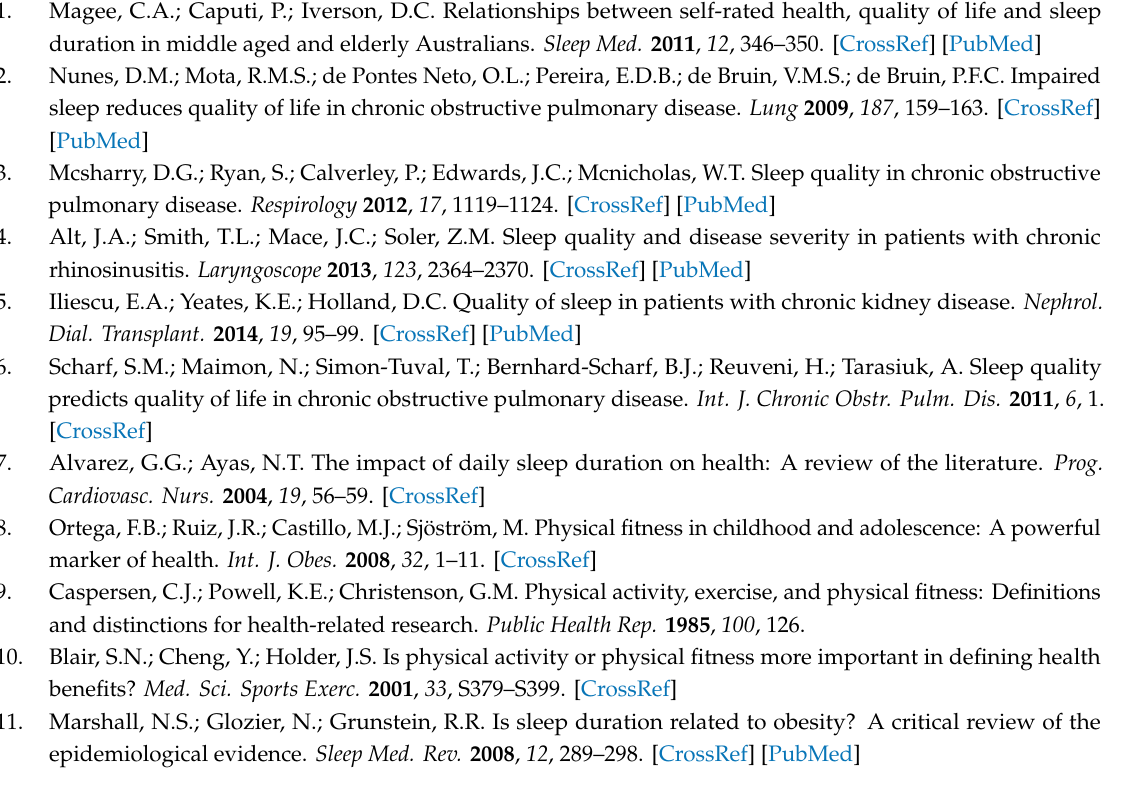
Table S1: Estimation results of the MARS model for BMI—male, Table S2: Estimation results of the MARS model for BMI—female, Table S3: Estimation results of the MARS model for sit-ups—male, Table S4: Estimation results of the MARS model for sit-ups—female, Table S5: Estimation results of the MARS model for sit-and-reach-male, Table S6: Estimation results of the MARS model for sit-and-reach—female, Table S7: Estimation results of the MARS model for CEI—male, Table S8: Estimation results of the MARS model for CEI—female. Figure S1: Trend diagram of the sleep condition and BMI—male, Figure S2: Trend diagram of the sleep condition and BMI—female, Figure S3: Trend diagram of the sleep condition and sit-ups—male, Figure S4: Trend diagram of the sleep condition and sit-ups—female, Figure S5: Trend diagram of the sleep condition and sit-and-reach—male, Figure S6: Trend diagram of the sleep condition and sit-and-reach—female, Figure S7: Trend diagram of the sleep condition and CEI—male, Figure S8: Trend diagram of the sleep condition and